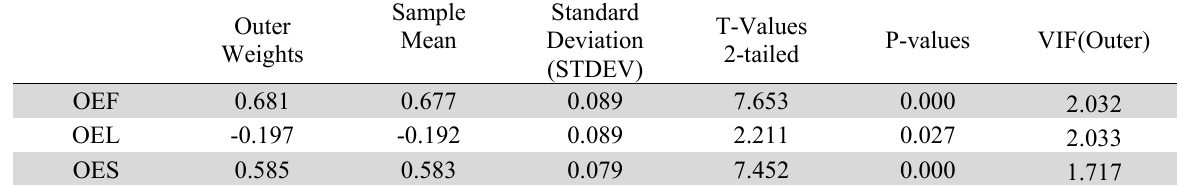
Inner VIF Values